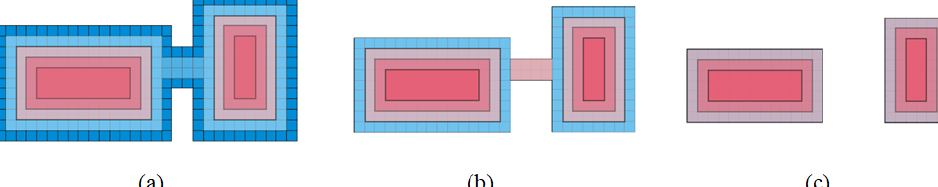
ISPRS Int. J. Geo-Inf. 2021 , 10 , x FOR PEER REVIEW